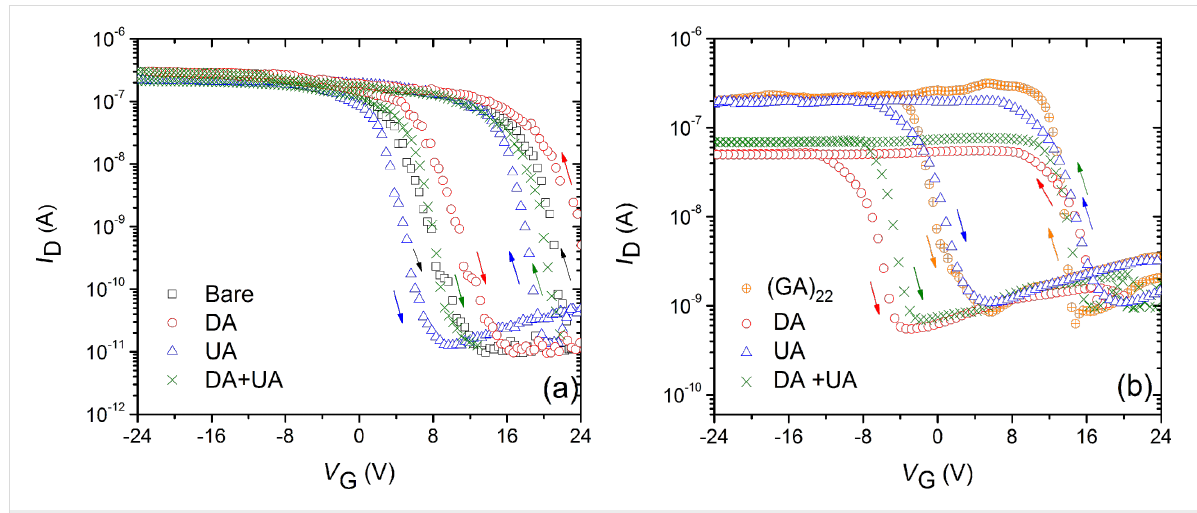
Figure 3: I D –V G curve of (a) bare SWCNT FET and (b) (GA) 22 -decorated SWCNT FET exposed to DA, UA and a DA–UA solution mixture. The arrows indicate the direction of the gate voltage sweep.